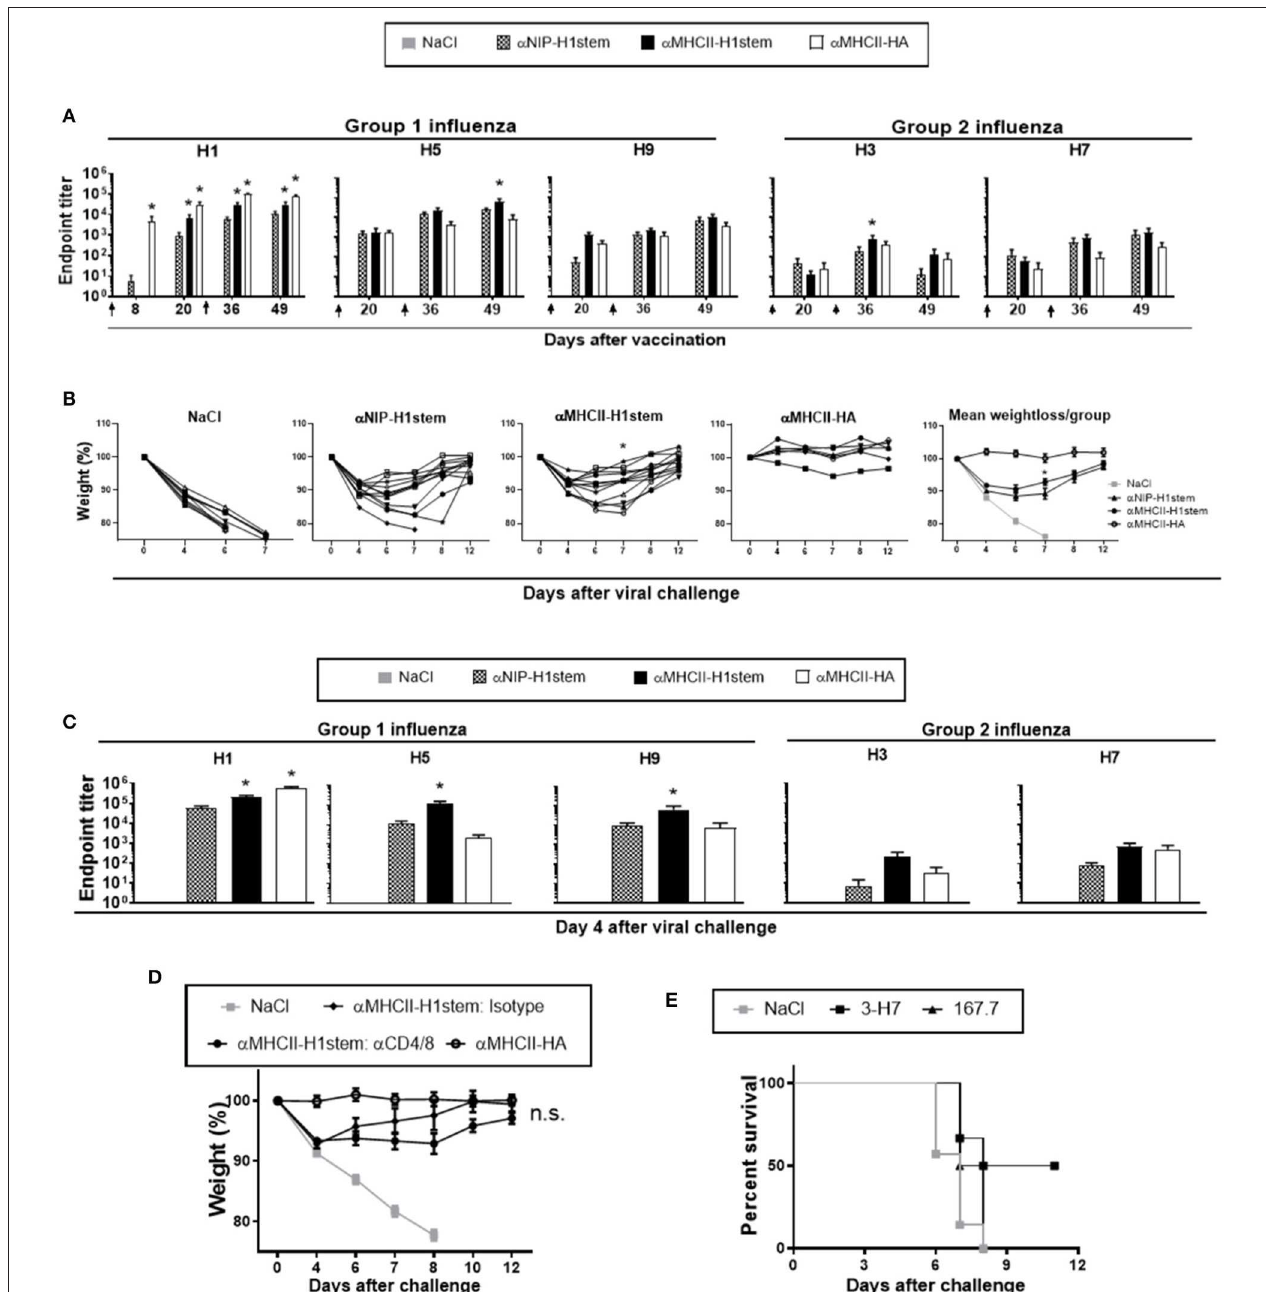
FIGURE 2 | Induction of cross-reactive and protective antibodies against influenza. (A–C) BALB/c mice ( n = 11–12 mice/group, except n = 6 for the α MHCII-HA group) were DNA-immunized twice on days 0 and 21, as indicated by arrows. (A) Sera were analyzed for development of IgG responses against recombinant HA from PR8, A/Hong Kong/1/1968 (H3N2), A/Hong Kong/483/97 (H5N1), A/Shanghai/1/2013 (H7N9), and A/Hong Kong/1073/99 (H9N2). A vaccine encoding full-length HA, α MHCII-HA, was included as positive control. Values given are mean ± SEM. * p < 0.05 as compared to α NIP-H1stem (two-way ANOVA and Bonferroni post-test). (B) 4 weeks after the final vaccination, mice were challenged with a 5 × LD50 dose of influenza PR8 and monitored for weight loss. * p < 0.05 for α MHCII-H1stem as compared to α NIP-H1stem (Mann–Whitney test). (C) Sera were harvested on day 4 after the influenza challenge and assayed for specific IgG responses against HA from PR8, A/Hong Kong/1/1968 (H3N2), A/Hong Kong/483/97 (H5N1), A/Shanghai/1/2013 (H7N9), and A/Hong Kong/1073/99 (H9N2) in ELISA. Values given are mean ± SEM. * p < 0.05 as compared to α NIP-H1stem (two-way ANOVA and Bonferroni post-test). (D) BALB/c mice were immunized twice (day 0 and 21) and then injected every other day with depleting mAbs against CD4 + - and CD8 + -T cells starting from day 48 ( n = 7 for α MHCII-HA, n = 8 for isotype treated, n = 11 for CD4/8 depleted, and n = 10 for NaCl). At day 50, mice were challenged with a 5 × LD50 dose of influenza PR8, and monitored for weight loss. (E) Hybridomas were generated after vaccination with α MHCII-H1stem (S5). Survival of BALB/c mice that were treated i.v. with monoclonal IgM 3-H7 specific for the HA stem or a matched isotype control (167.7), and challenged 24h later with a 5 × LD50 dose of influenza PR8.